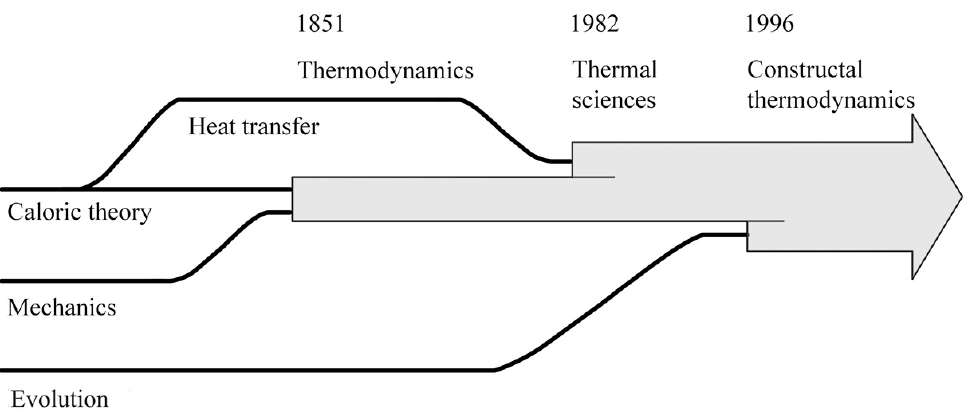
Figure 9. The evolution and spreading of thermodynamics during the past two centuries [17].